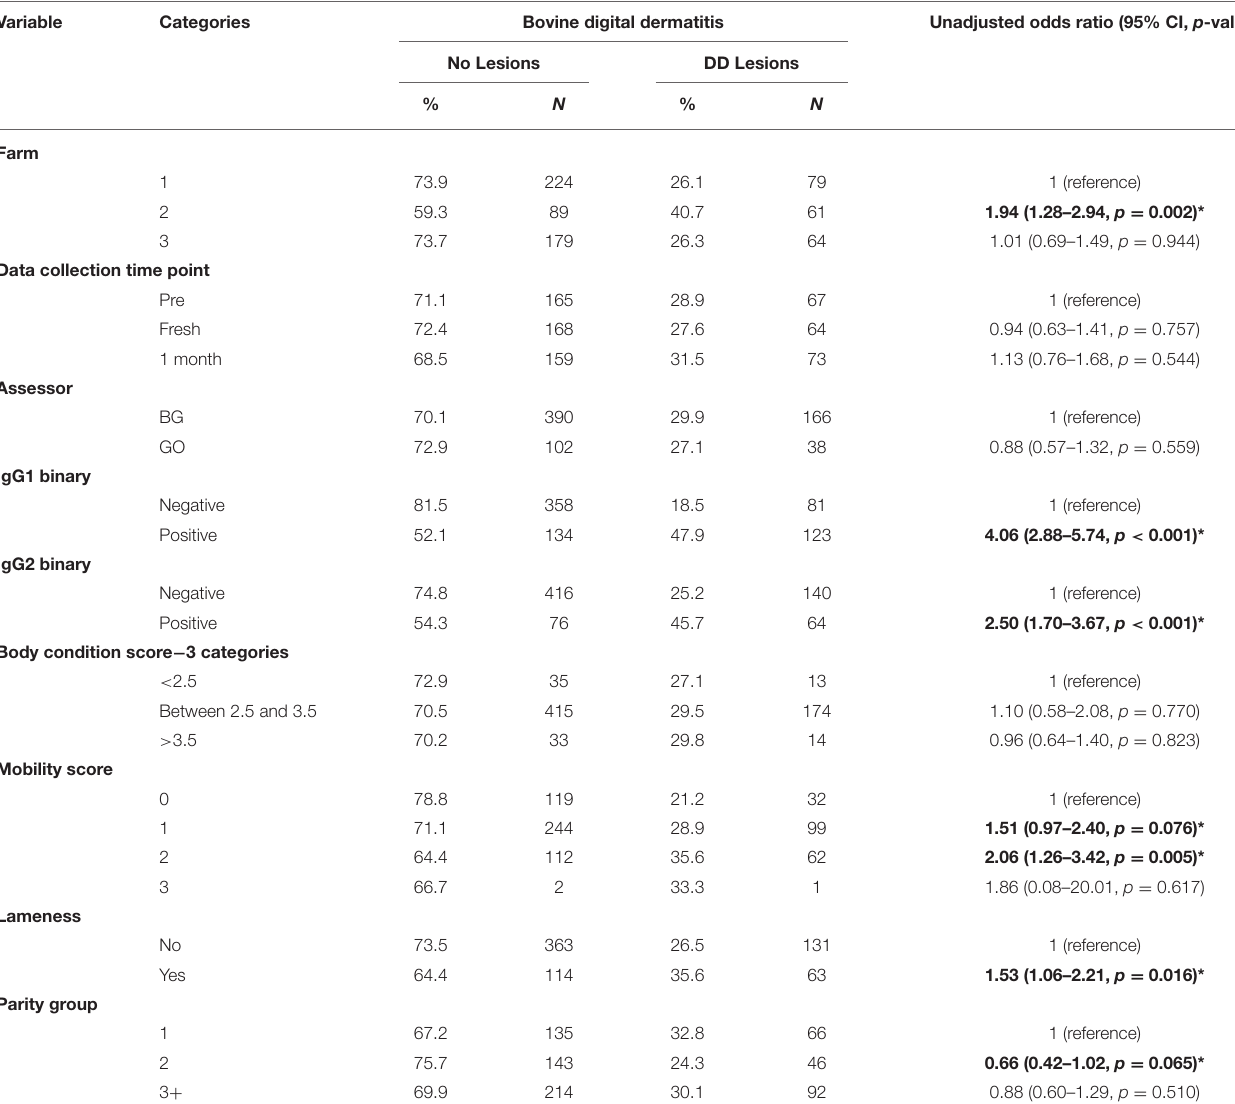
TABLE 5 | Risk factors for the presence of DD lesions regardless of the affected hoof in a univariate logistic regression model.